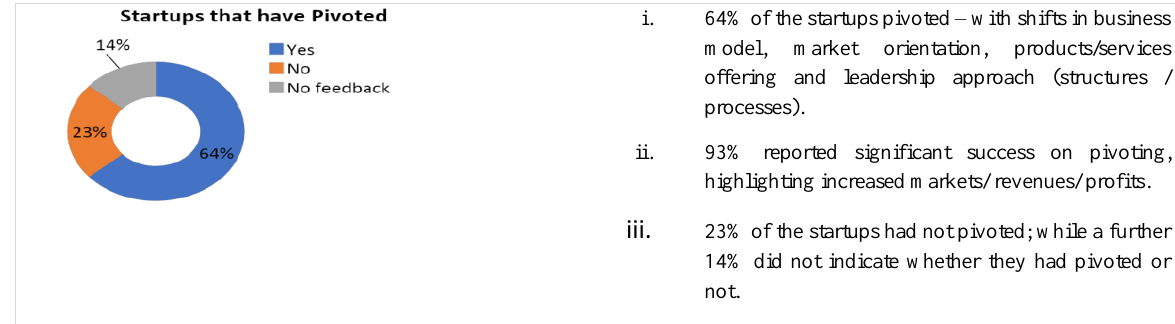
Figure 6: Startups that have pivoted